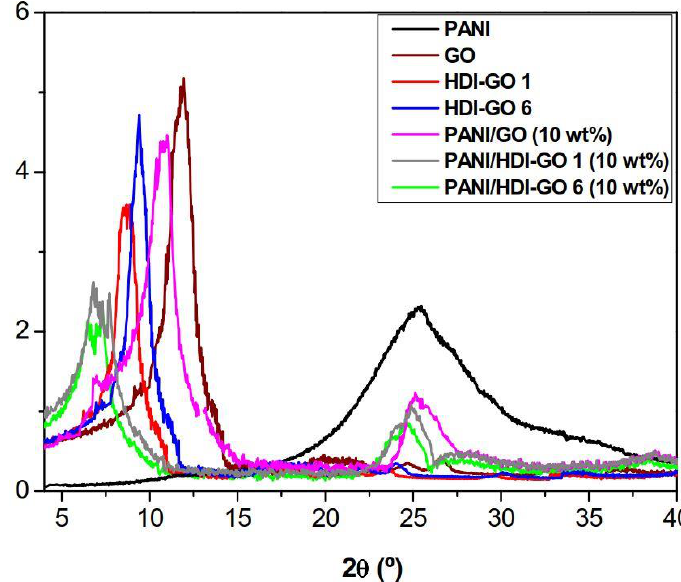
Figure 2. XRD patterns of neat PANI, raw graphene oxide (GO), hexamethylene diisocyanate-modified GO (HDI-GO) 1, HDI-GO 6, and the corresponding nanocomposites with 10 wt % nanofiller content.